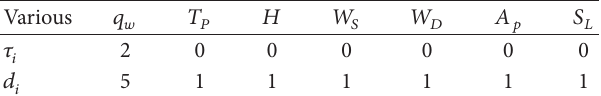
Table 1: Delay time 𝜏 𝑖 and embedding dimension 𝑑 𝑖